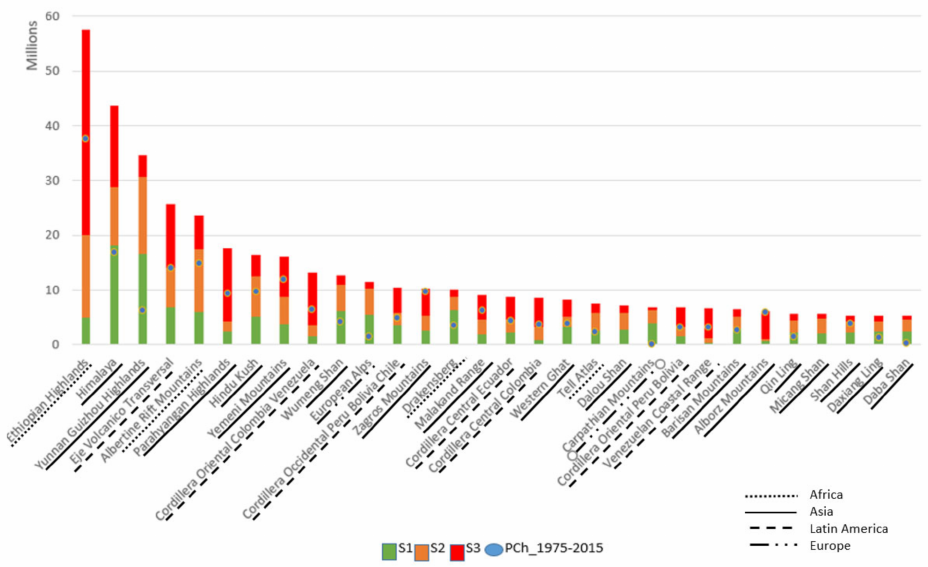
Figure 5. Population total for 30 most populated GMBA ranges with shares of Rural population (S1), Towns (S2), Cities (S3) for 2015, and Population changes over the 1975–2015 timeframe